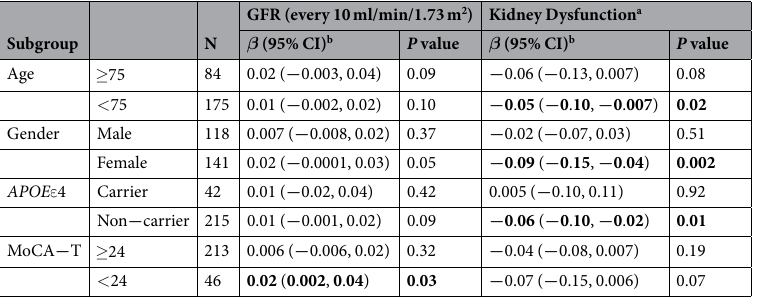
Table 4. Association of kidney function and global CTh by multiple linear regression models, stratification by important factors. a Kidney dysfunction is defined as either GFR < 60 ml/min/1.73 m 2 or presence ( ≥ 1 + ) of proteinuria. b The models were routinely adjusted for factors including age, gender, education years, APOE ε 4 carrier status, MoCA-T score, and intracranial volume, except the factors used for stratifications. Numbers in bold indicated significant findings.